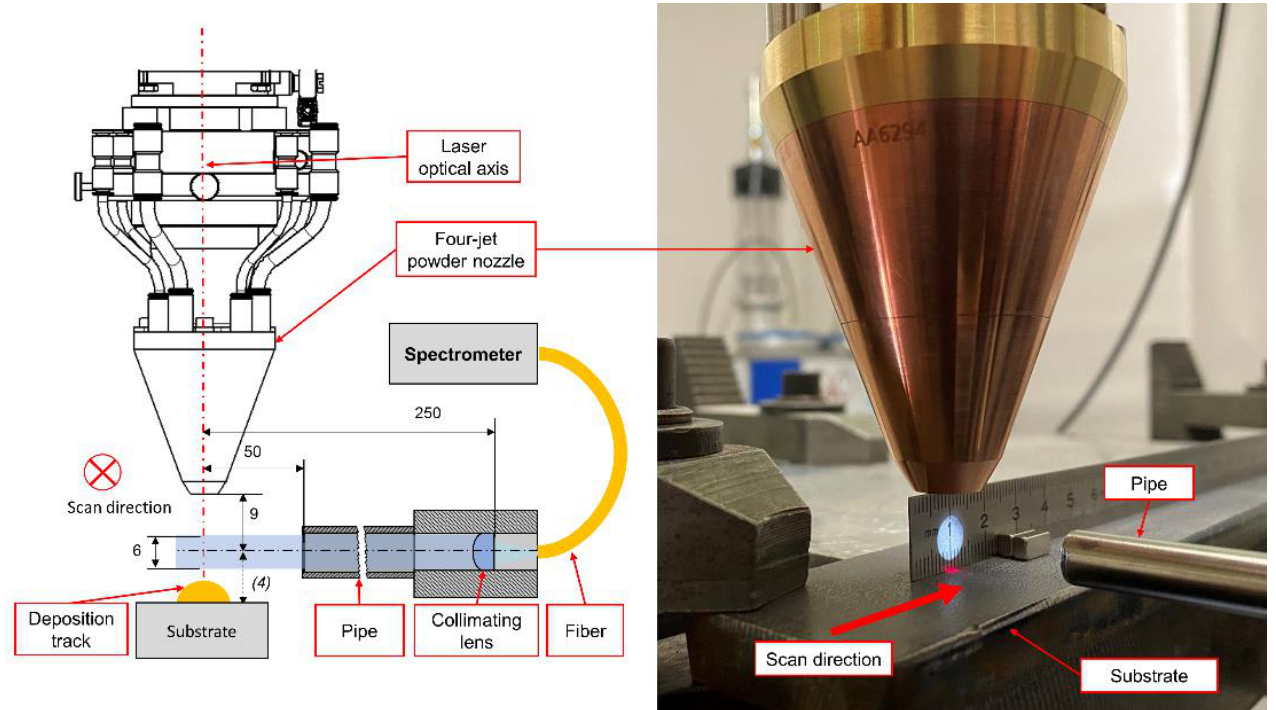
Figure 2. Measurement setup and collimation lens alignment.